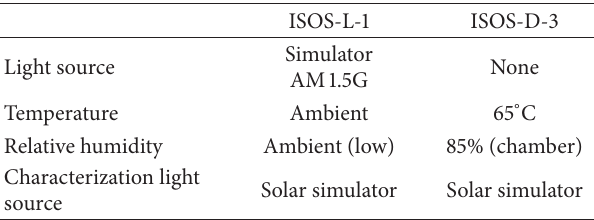
Table 2: Properties of ISOS-L-1 and ISOS-D-3